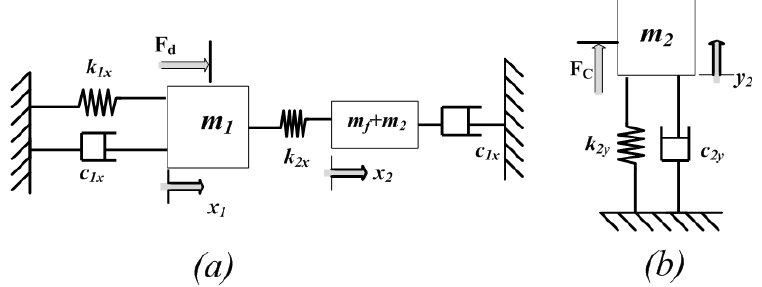
Figure 7. (a) Lumped mass-spring-damper model for 2-DoF drive mode oscillator (b) lumped mass-spring-damper model for 1-DoF sense mode oscillator of 3-DoF